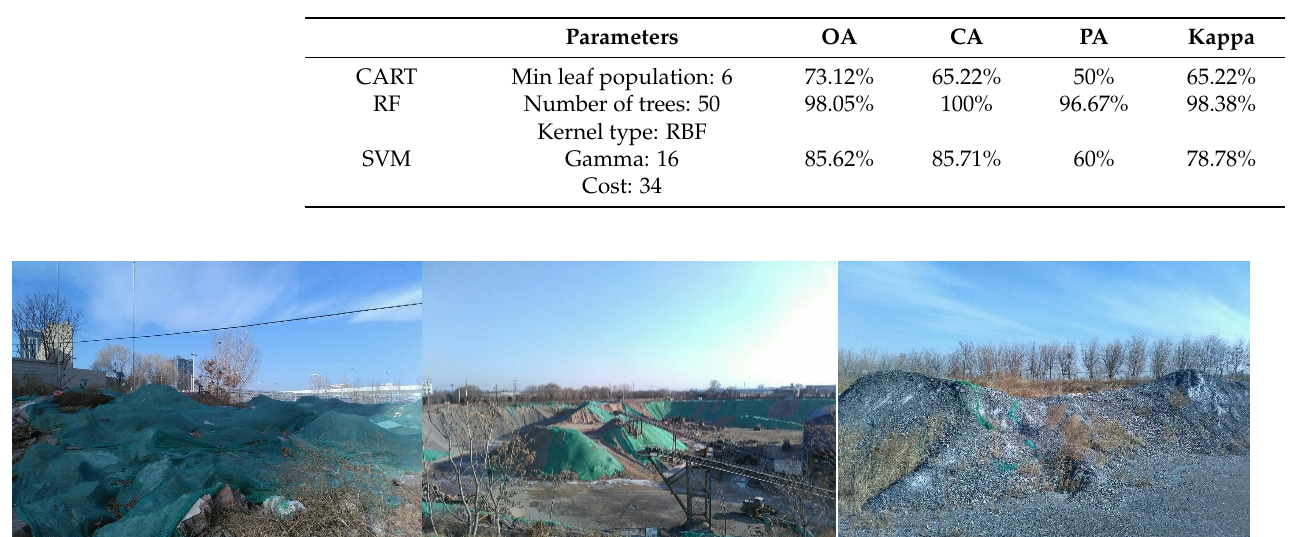
CA: consumer accuracy; PA: producer accuracy; RBF: radial basis function.